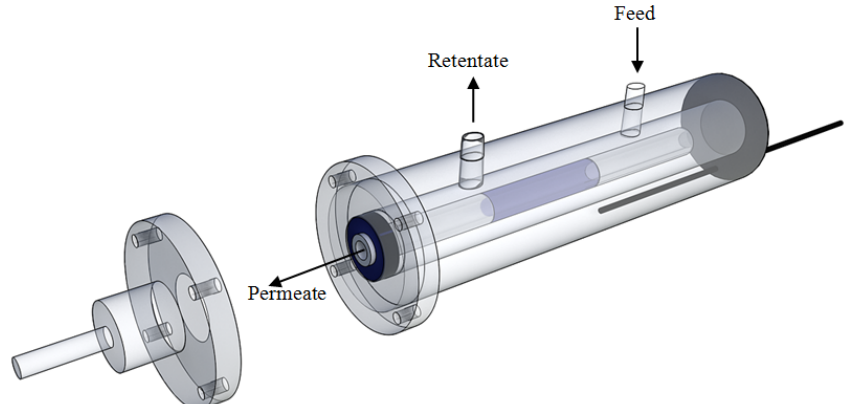
Figure 1. Scheme of membrane module housing the Pd/porous stainless steel (PSS) membrane.